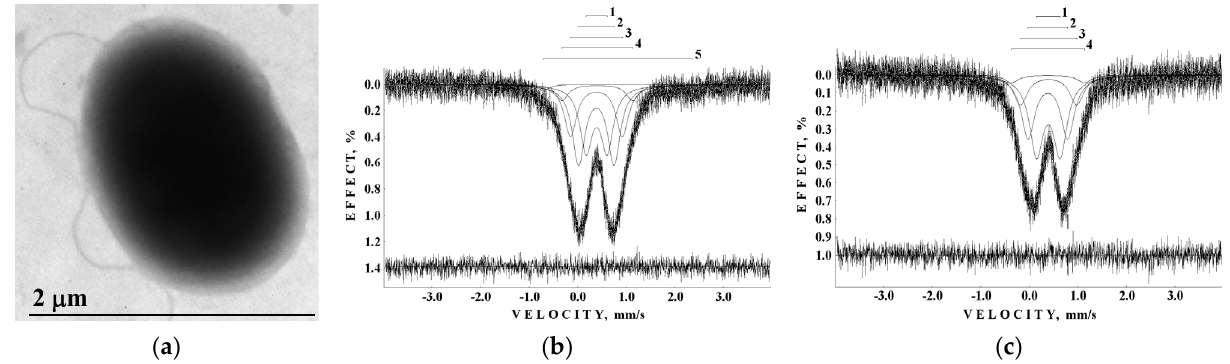
Figure 19. Transmission electron microscopy image of the rhizobacterium Azospirillum brasilense (strain Sp245) ( a ) and Mössbauer spectra of bacteria samples 1 ( b ) and 2 ( c ). Indicated components 1–4 are the results of the best fits within the new heterogeneous model for the iron core with equal line width for four ferritin ‐ like components. Component 5 in the spectrum b corresponds to ferrous compound. The differential spectra are shown on the bottom. Adapted from Ref. [64] with permission from Elsevier: Journal of Molecular Structure, Vol. 1073, Alenkina I.V., Oshtrakh M.I., analysis of ferritin ‐ like iron cores”, 181–186, ©2014.